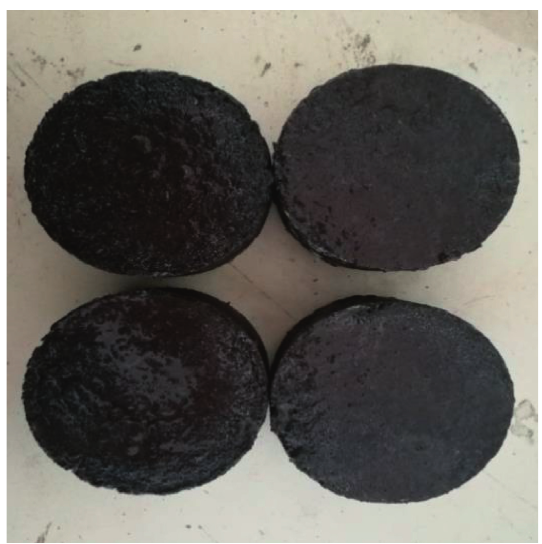
Figure 4: Fog-sealed Marshall